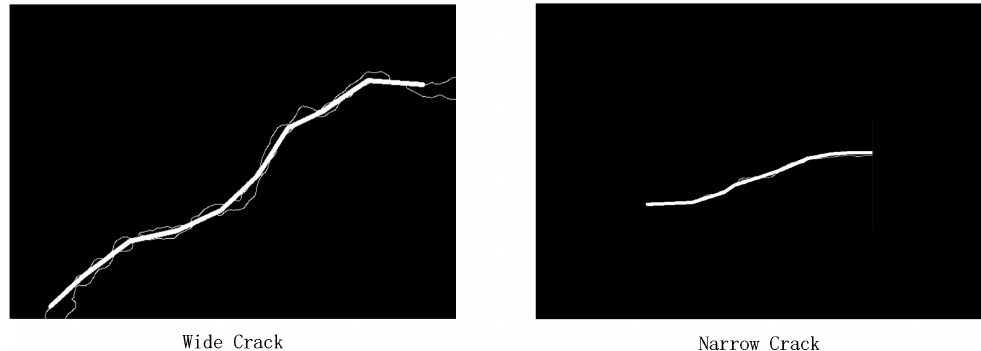
Figure 15. Algorithm fitting